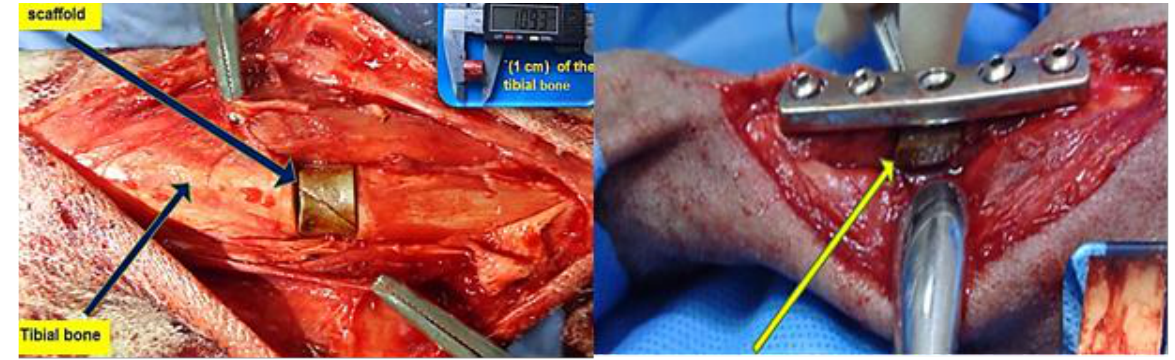
Figure 2. Photographs of the surgical procedure of creating a defect in tibial bone (black arrow) and scaffold implantation into the defect area in a canine model.The defect is well replaced with sterilized 3D scaffolds (blue arrow) and immobilized by bone plate and